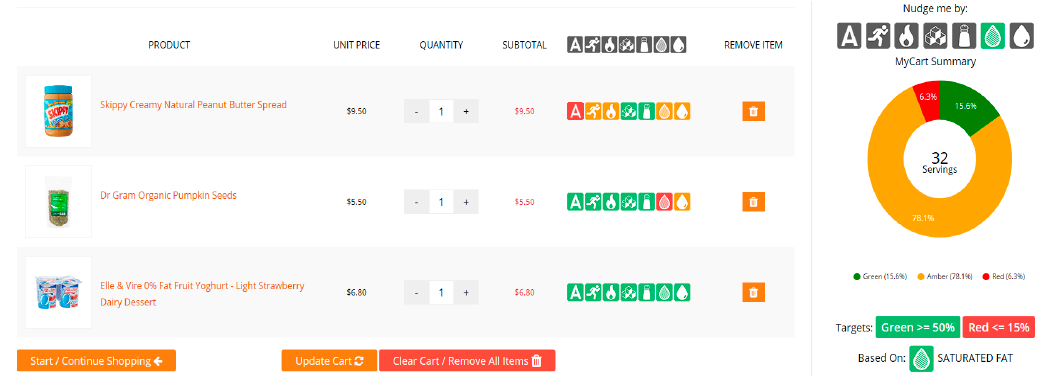
Figure 3. A screenshot of a shopping basket summary along with MyCart Summary.